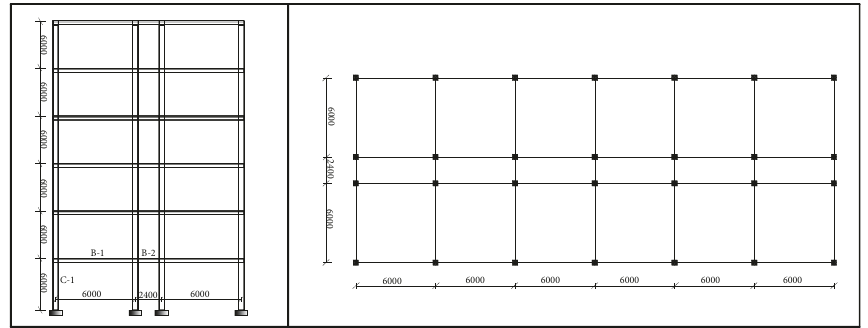
Figure 2: The plane and elevation views of the designed frame structure.